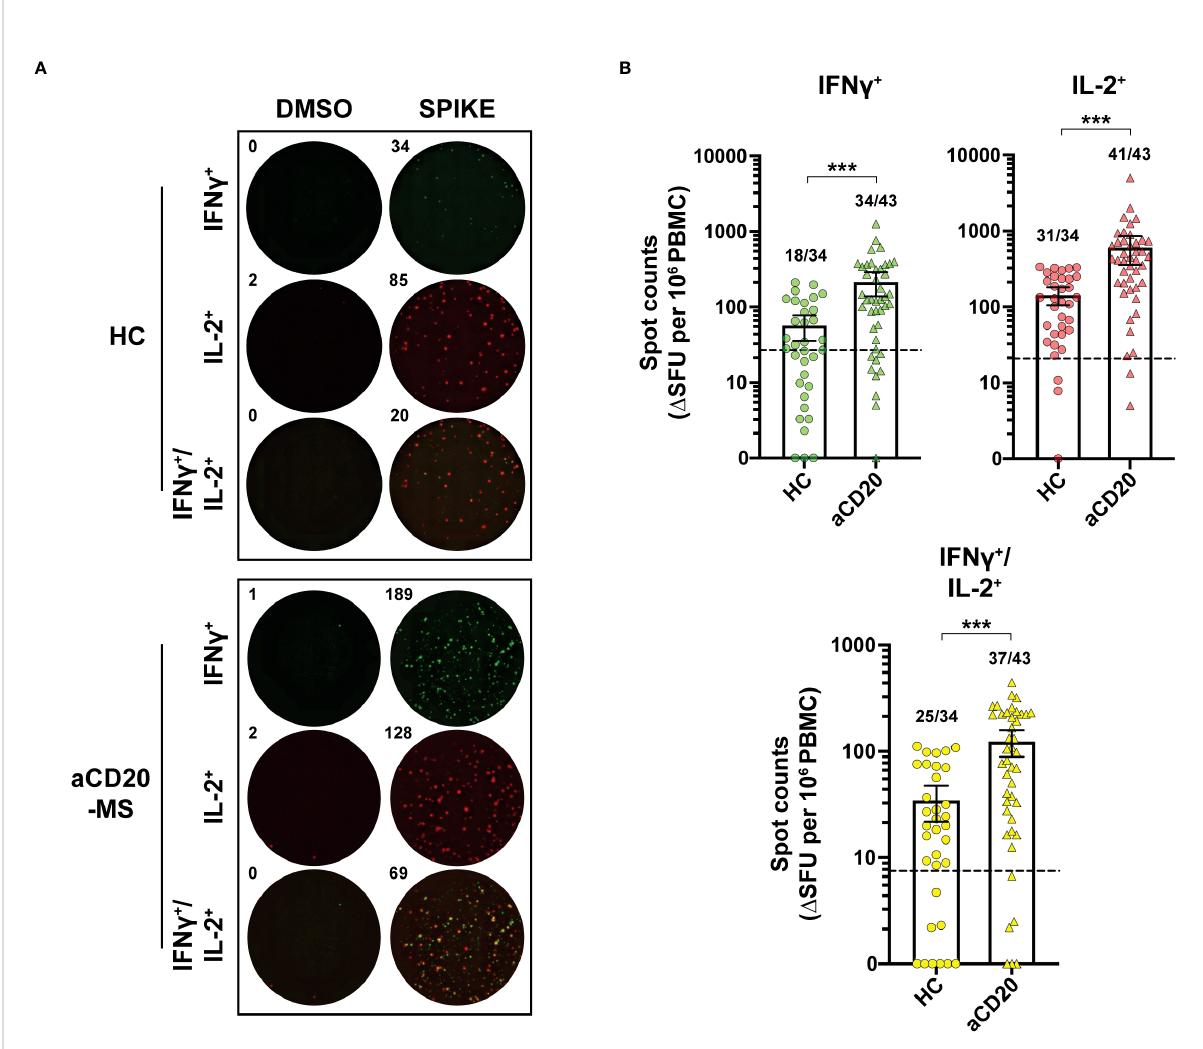
FIGURE 2 Increased IFN g + , IL-2 + and polyfunctional IFN g + /IL-2 + T-cell response in aCD20-MS compared to healthy control group. (A, B) PBMCs from healthy controls and aCD20-MS patients were placed into IFN g and IL-2 FluoroSpot plates (ImmunoSpot) and stimulated with DMSO negative control (0.4%) and a 15-mer full overlapping spike peptide pool (1 µg/mL) for 24 hours. (A) Representative IFN g + (green), IL-2 + (red) and IFN g + /IL-2 + (yellow) FluoroSpot data after antigen incubation of PBMCs from one aCD20-MS patient and one healthy control individual. (B) Comparison of the magnitude of IFN g + (green), IL-2 + (red) and IFN g + /IL-2 + (yellow) T-cell response in healthy controls (circles, n=34) and aCD20-MS patients (triangles, n=43). Data are DMSO-negative control subtracted and presented as D SFU per million PBMC. Dotted line indicates mean + 2xS.D. threshold obtained from unexposed controls (IFN g + = 27, IL-2 + = 20.8, IFN g + /IL-2 + = 7.5) (see Figure S1). Fractions of samples above threshold are indicated on top of each dataset. Box plots represent mean and 95% CI. ***P < 0.001; Mann-Whitney U tests. See also Figures S1 –